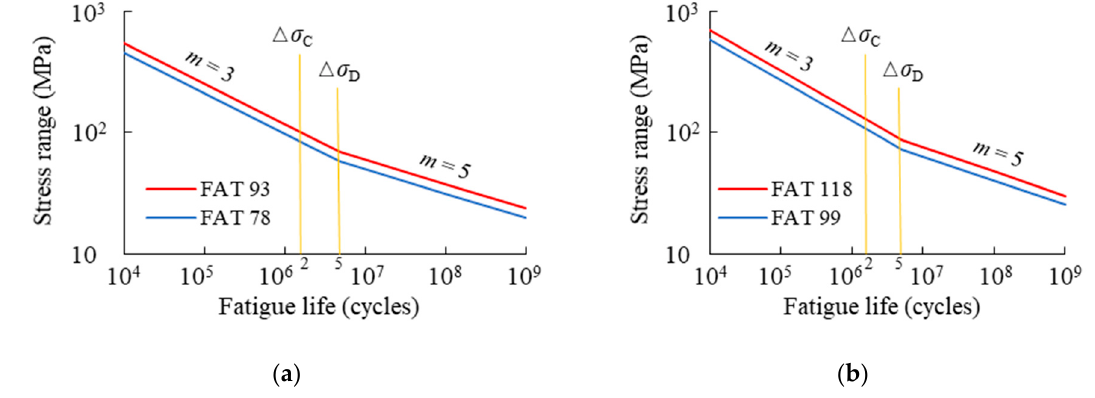
Figure 14. Modified stress-life curves for rib-to-deck joints: ( a ) OSDs with CUs; ( b ) OSDs with TEUs.